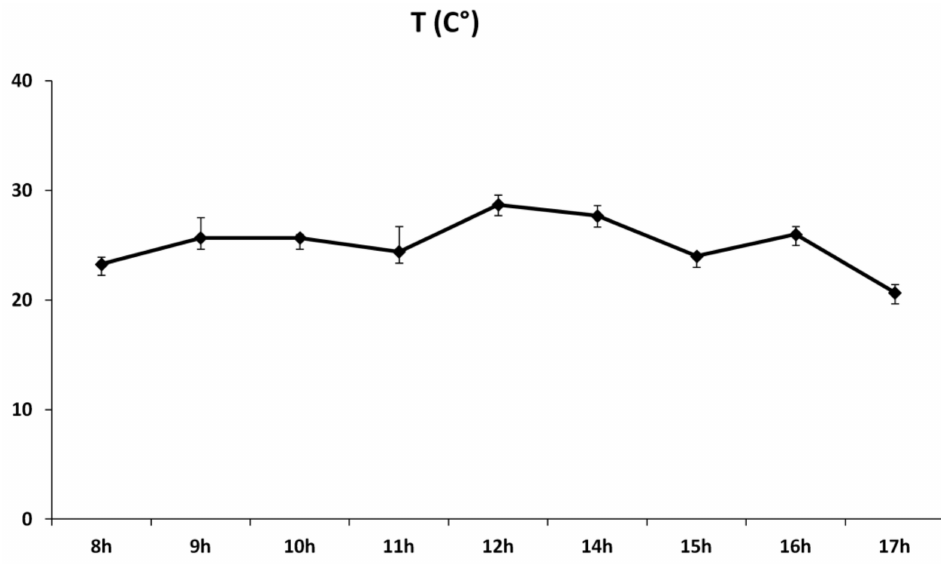
Figure A1. Variation of the Mean Temperature during Stress